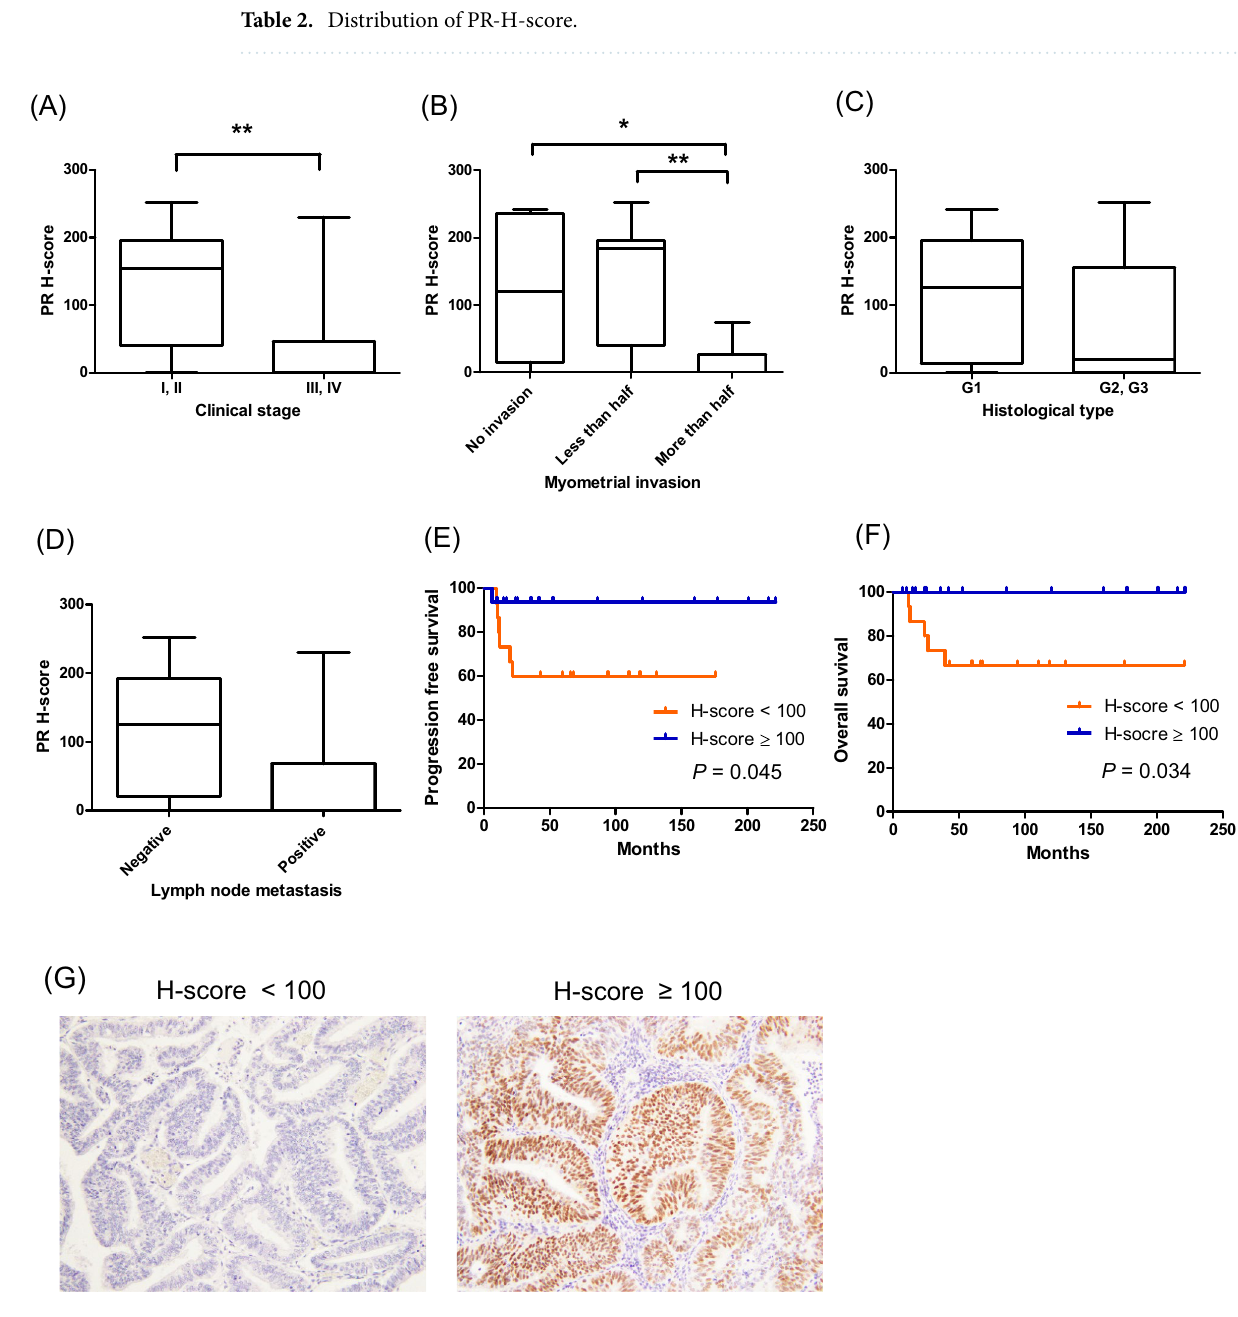
Figure 1. Expression of progesterone receptor (PR) in endometrial tissues of young patients with endometrial cancer. ( A )–( C ) Association of PR expression with clinico-pathological factors. The PR expression levels examined by immunohistochemical analysis were evaluated by H-score, and their association with clinical parameters, including clinical stage based on FIGO 2008 classification ( A ), myometrial invasion ( B ), histopathological type ( C ), and lymph node metastasis ( D ) are presented. Statistical significance was determined by using two-tailed unpaired Student’s t-test and one-way analysis of variance (ANOVA) with post-hoc Tukey’s multiple comparison test. Kaplan–Meier analysis of progression-free survival ( E ) and overall survival ( F ) is shown in association with PR expression ( G ). * P < 0.05; ** P <